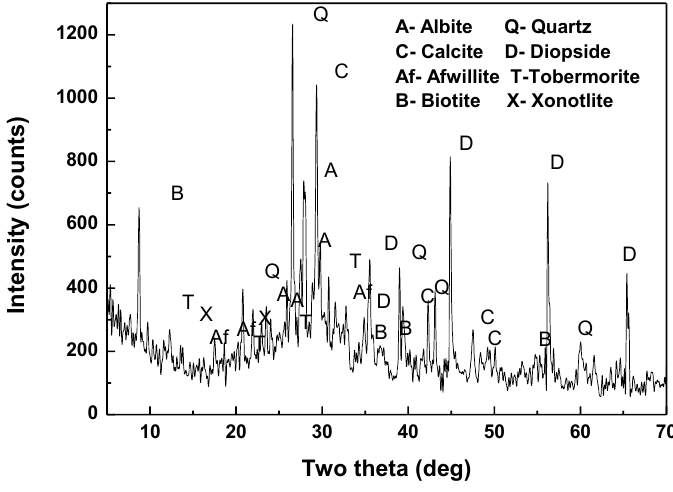
Figure 7. XRD pattern of autoclaved bricks by optimum aggregate gradation and the autoclave system.